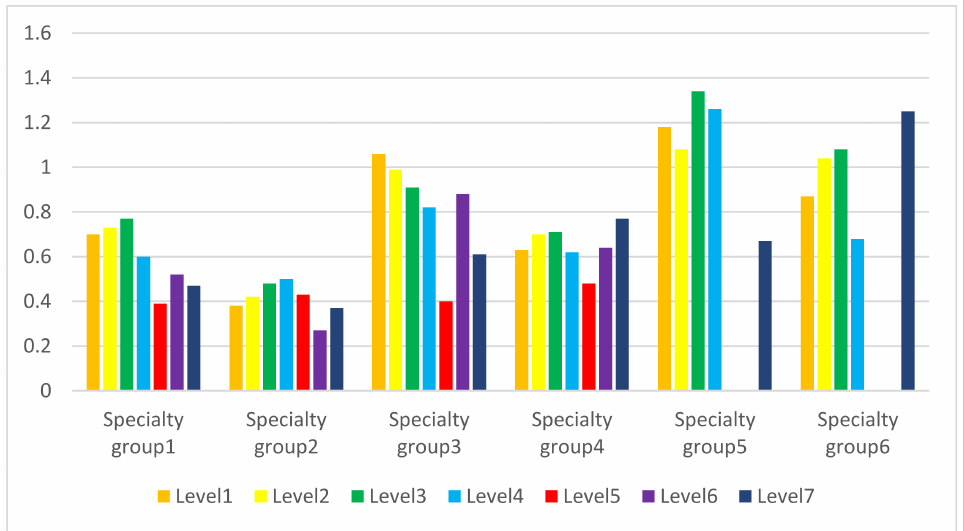
Figure 2. The average number of pharmacists at clinics by urbanization level and specialty group. We grouped specialty into six clusters according to their sample size and clinical pattern. The internal medicine-related departments were grouped as group one. Surgery-related specialties were grouped as group two. Department of facial features (otolaryngology and ophthalmology) and pediatrics (patient’s condition being similar to those in otolaryngology) were clustered as group three. The remaining specialties were classified as group four. Due to the highest percentage of pharmacists at clinics and their specific specialty attributes, dermatology and psychiatry were independently grouped into groups five and six, respectively. There were almost no clinics of specialty groups 5 or 6 in level 5 or 6 townships, so data were not applicable